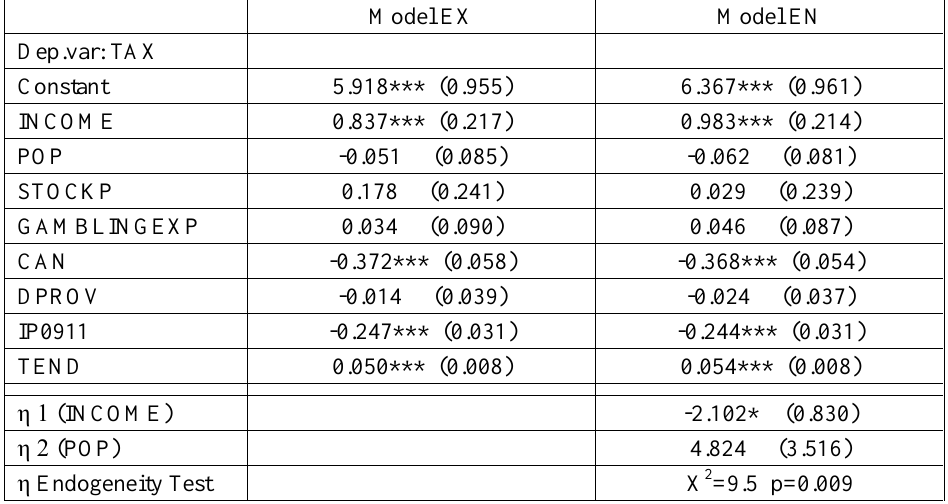
Table 4 : Results of the estimates of endogenous SFA in the style of Karakaplan and Kutlu